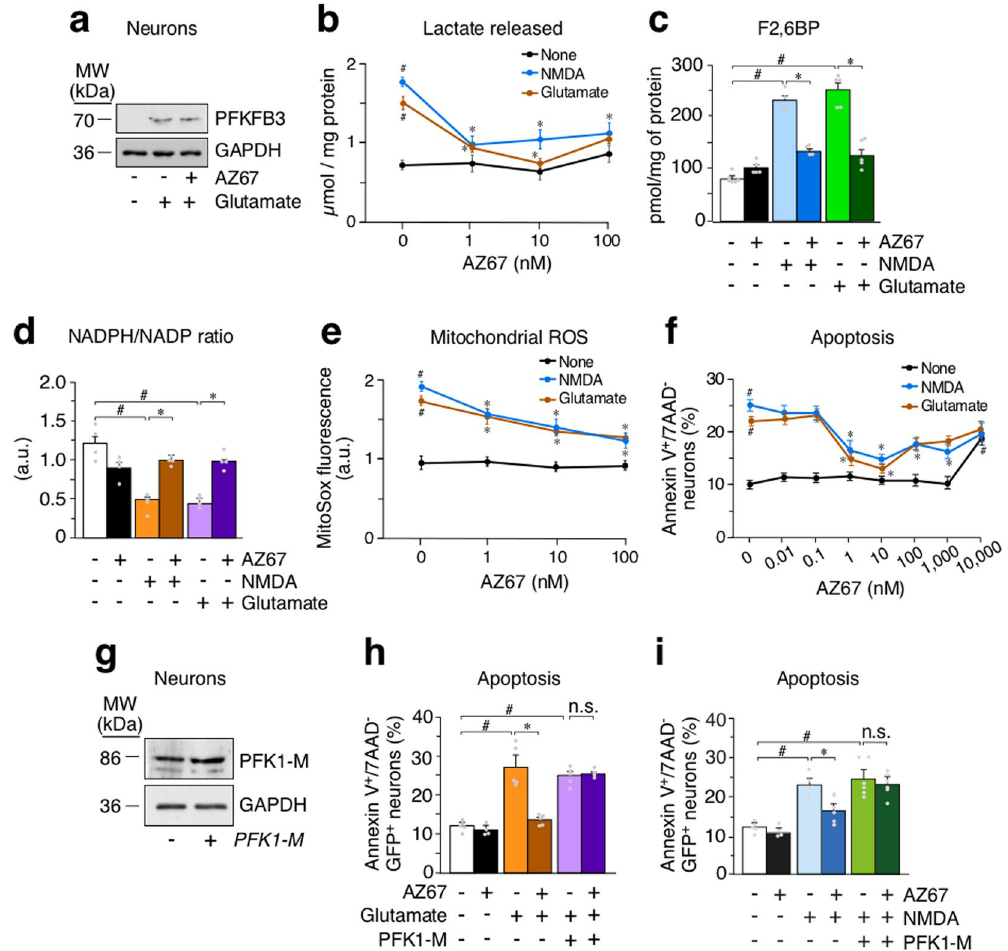
Figure 2. AZ67 prevents glycolytic activation, redox stress and neuronal death upon excitotoxic stimuli in primary neurons. (a) Western immunoblotting showing that the treatment of neurons with glutamate (100 µ M; 10 mins), followed by washout, stabilized PFKFB3 protein levels after 24 h of incubation. Incubation of neurons with AZ67 (10 nM) for 24 h, after glutamate was removed, did not alter PFKFB3 protein levels. (b) Incubation of neurons with AZ67 for 24 h revealed no effect on lactate release. Treatment of neurons with NMDA (100 µ M; 10 mins) or glutamate (100 µ M; 10 mins), followed by washout, increased lactate released after 24 h of incubation (compare NMDA or glutamate versus none values at 0 nM AZ67). Incubation of neurons with AZ67 for 24 h, after NMDA or glutamate was removed, dose-dependently prevented the increase in lactate release. (c) Incubation of neurons with AZ67 for 24 h revealed no effect on F2,6BP concentrations. Treatment of neurons with NMDA (100 µ M; 10 mins) or glutamate (100 µ M; 10 mins), followed by washout, increased F2,6BP after 24 h of incubation. Incubation of neurons with AZ67 (10 nM) for 24 h, after NMDA or glutamate was removed, prevented the increase in lactate release. (d) Incubation of neurons with AZ67 for 24 h revealed no significant effect on the NADPH/NADP ratio. Treatment of neurons with NMDA (100 µ M; 10 mins) or glutamate (100 µ M; 10 mins), followed by washout, decreased the NADPH/NADP ratio after 24 h of incubation. Incubation of neurons with AZ67 (10 nM) for 24 h, after NMDA or glutamate was removed, prevented the decreased NADPH/ NADP ratio. (e) Incubation of neurons with AZ67 for 24 h revealed no effect on mitochondrial ROS. Treatment of neurons with NMDA (100 µ M; 10 mins) or glutamate (100 µ M; 10 mins), followed by washout, increased mitochondrial ROS after 24 h of incubation (compare NMDA or glutamate versus none values at 0 nM AZ67). Incubation of neurons with AZ67 for 24 h, after NMDA or glutamate was removed, dose-dependently prevented the increase in mitochondrial ROS. (f) Treatment of neurons with NMDA (100 µ M; 10 mins) or glutamate (100 µ M; 10 mins), followed by washout, triggered apoptotic death after 24 h of incubation (compare NMDA or glutamate versus none values at 0 nM AZ67). Incubation of neurons with AZ67 for 24 h, after NMDA or glutamate was removed, dose-dependently prevented apoptotic death up to 10 nM, AZ67; at concentrations of 100 nM to 10 µ M, AZ67 showed progressive loss of protection. (g) Transfection of primary neurons with Pfk1-M (4 µ g of DNA plasmid) efficiently increased PFK1-M protein levels. (h) Treatment of neurons with glutamate (100 µ M; 10 mins), followed by washout, triggered apoptotic death after 24 h of incubation. Incubation of neurons with AZ67 (10 nM) for 24 h, after glutamate was removed, prevented apoptotic death. However, AZ67- mediated protection of apoptotic death was abolished when neurons were previously transfected with the full- length cDNA coding for PFK1-M. Apoptosis was analysed only in the efficiently-transfected, GFP + neurons. (i) Treatment of neurons with NMDA (100 µ M; 10 mins), followed by washout, triggered apoptotic death